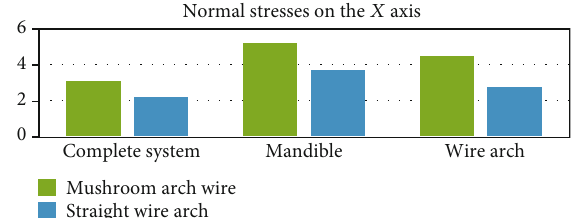
Figure 24: Normal stresses in the X axis (MPa). The graph shows a comparison between the stresses in the X axis that were generated in each of the analyzed sections: complete system (mandibular bone, dental organs, brackets, and wires) and separately the mandible and the two di ff erent types of arches or